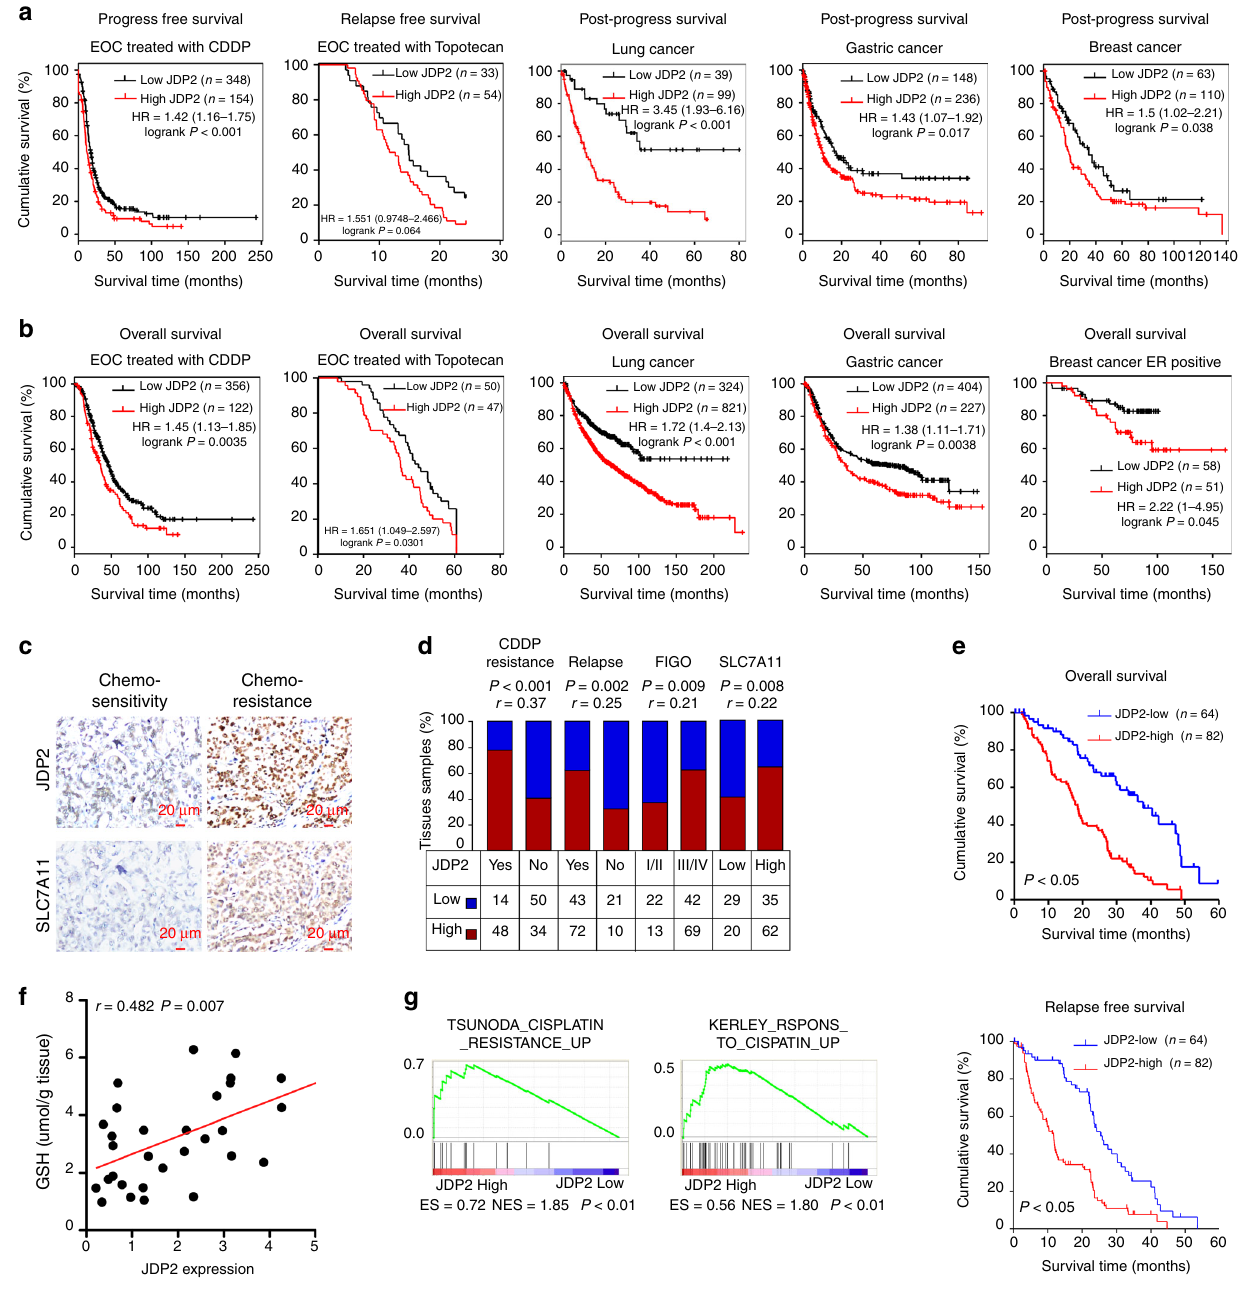
Fig. 7 JDP2 level correlates with poorer survival of patients with cancer. a , b Online Kaplan – Meier plotter analysis revealed that patients with ovarian, lung, gastric, or breast cancer exhibiting high JDP2 expression had signi fi cantly shorter progression-free survival and shorter overall survival than patients with low JDP2 expression ( P < 0.05, log-rank test; n = the indicated biologically independent samples). c Representative images of JDP2 and SLC7A11 in chemo- sensitive and chemo-resistant ovarian cancer tissues ( n = 146). Scale bar, 20 μ m. d Positive correlation of JDP2 levels with CDDP resistance ( P < 0.001; r = 0.37), relapse ( P = 0.002; r = 0.25), FIGO stage ( P = 0.009; r = 0.21), and SLC7A11 expression ( P = 0.008; r = 0.22) in ovarian cancer tissues ( n = 146). Spearman rank correlation analysis. e Kaplan – Meier analysis of 5-year overall survival (upper) and 5-year disease-free survival (lower) for patients with ovarian cancer strati fi ed by low versus high expression of JDP2 (log-rank test; P < 0.05, P < 0.05, respectively; n = 146). Quanti fi cation of IHC using the staining index (see Supplementary Materials and Methods). Samples with an SI ≥ 8 were determined as high expression, and samples with an SI < 8 were determined as low expression ( n = the indicated biologically independent samples). f Positive correlation between JDP2 expression and GSH levels ( P = 0.007; r = 0.482) in 30 freshly collected ovarian cancer tissues. two-tailed Spearman test. g Gene set enrichment analysis (GSEA) plot showing that JDP2 expression correlated positively with cisplatin-resistance-activated gene signatures (TSUNODA_CISPLATIN_RESISTANCE_UP) in published gene expression pro fi les of patients with ovarian cancer (NCBI/GEO/GSE66957, n = 69) and in gene expression pro fi les of patients with breast cancer (TCGA, n =